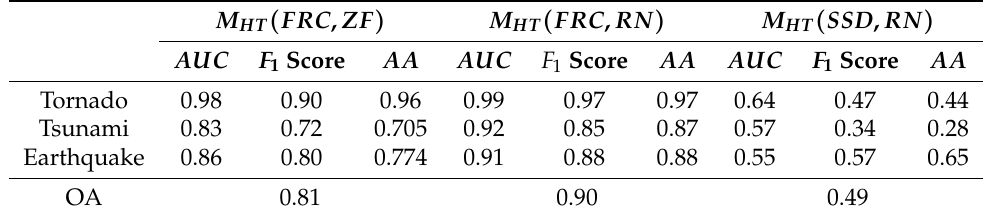
Table 3. Performance of hazard-type